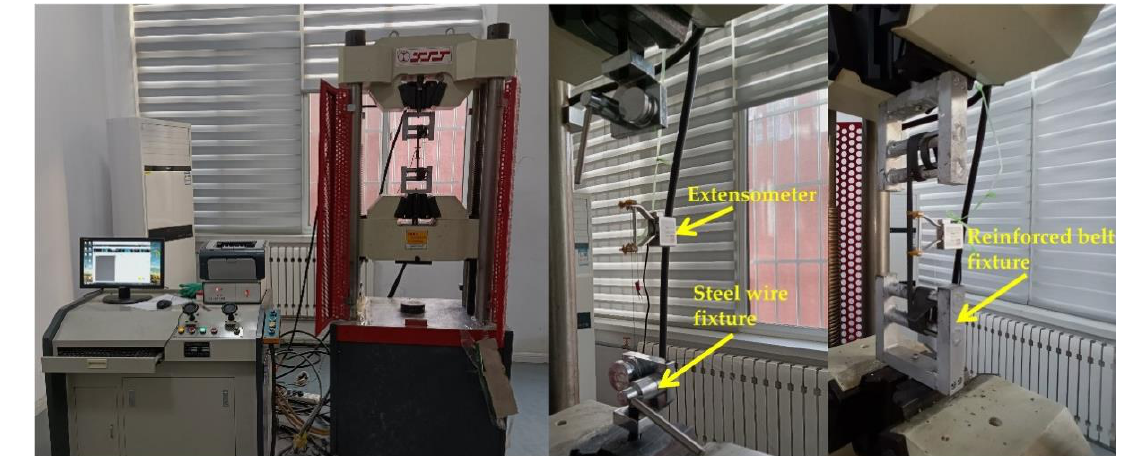
Figure 3. Test equipment and exclusive